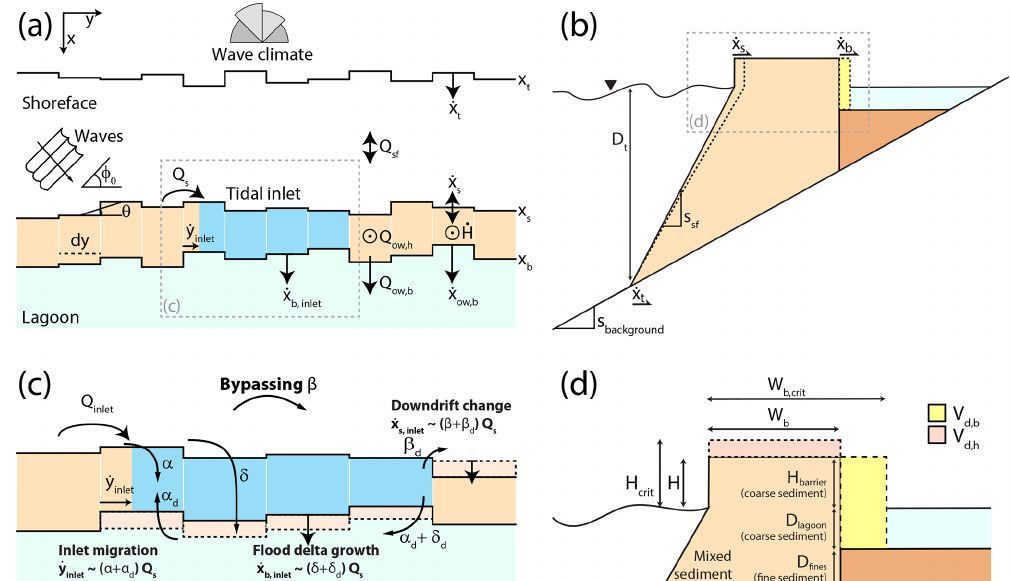
Figure 1. Schematized model domain in (a) the plan view highlighting the three moving boundaries (the shoreface toe, shoreline, and the back-barrier (lagoon) location) and the sediment fluxes that determine their coupling. Vectors indicate the direction of potential changes, with the dot symbolizing a movement up. (b) Implementation of fine sediment dynamics into the barrier overwash model. (c) A close-up of (a) , showing the littoral sediment fractionation within an inlet and its translation to barrier change. (d) A close-up of (b) , showing the barrier volume deficit approach. See Table 1 for model variable names and units.